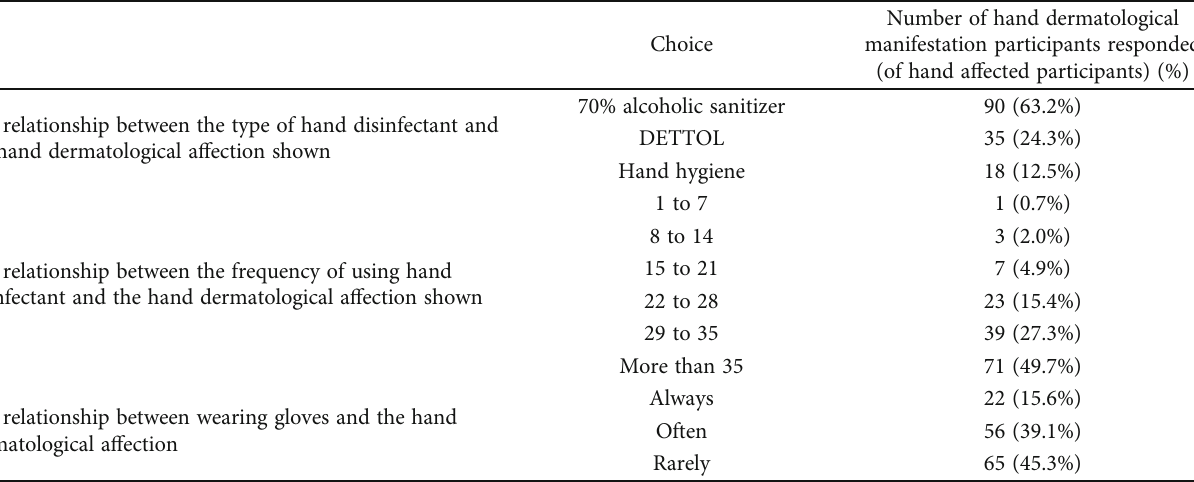
Table 7: The relationships between hand dermatological manifestation and possible cause for it in the 143